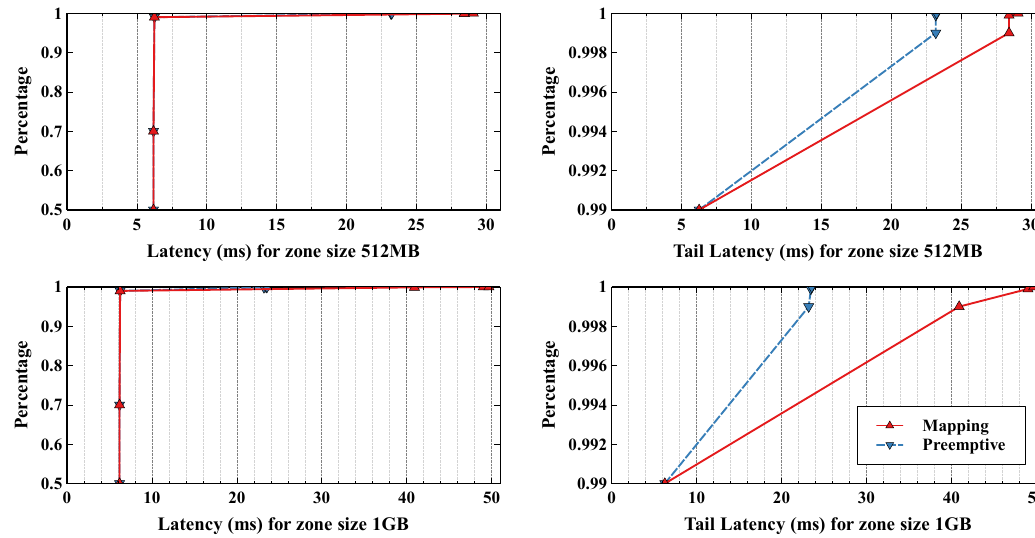
Figure 6. fio latency for sequential writes.